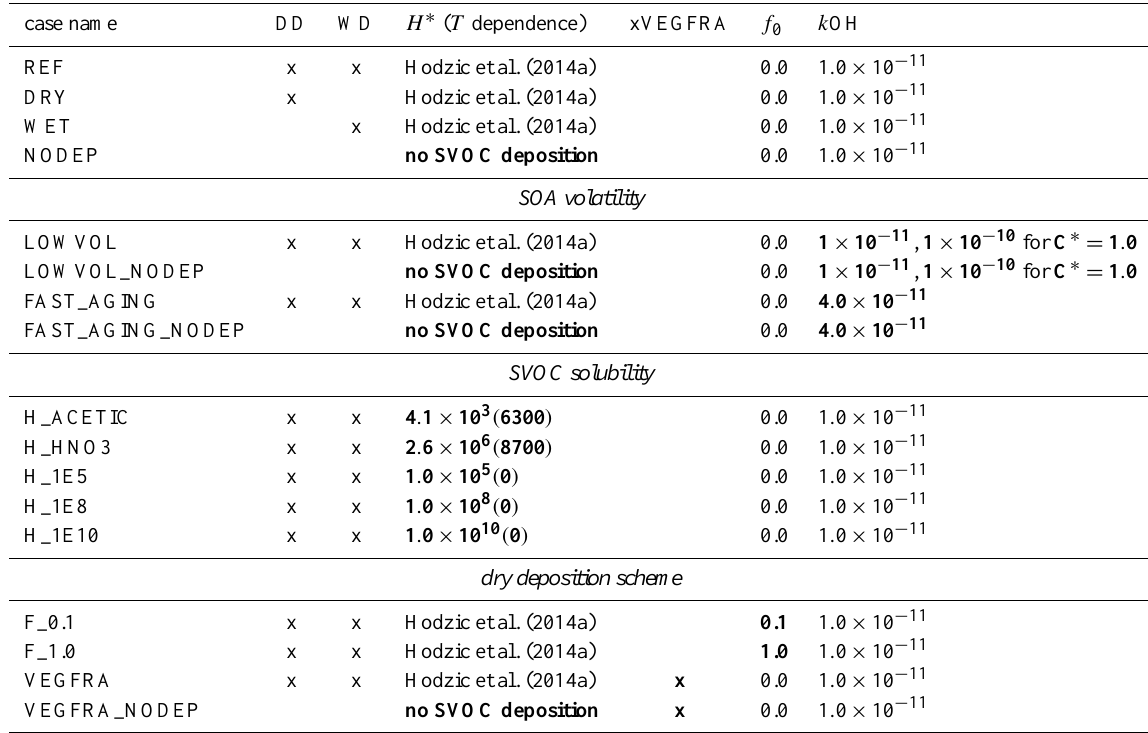
Table 3. Simulations conducted. DD/WD denotes if dry/wet deposition of SVOCs is considered, and H ∗ refers to the Henry’s law constants used for SVOCs. xVEGFRA states whether dry deposition velocities are scaled by the vegetation fraction of each grid cell (see text). kOH denotes the aging rate constant (SVOC + OH) and f 0 to the reactivity parameter in the Wesely (1989) dry deposition scheme. kOH is reported as cm 3 molec − 1 s − 1 , H ∗ as Matm − 1 , the temperature dependence as − dln (H ∗ )/ d ( 1 /T ) . Parameters varied compared to the REF simulation are shown in bold